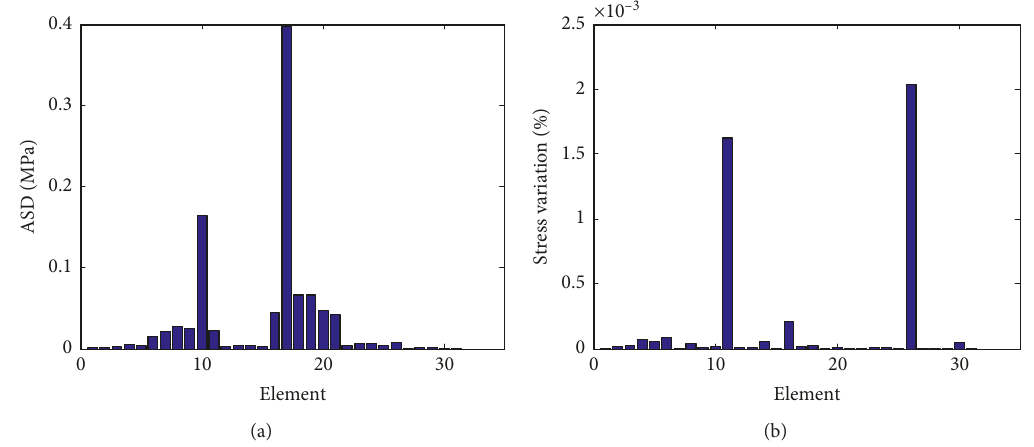
Figure 17: Multiple damages at elements 10 , 17 , and 26 using noise-free displacements and local-based approach of (a) ASD and (b) stress variation rate.